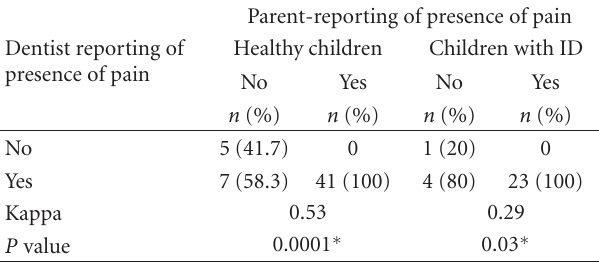
Table 4: Agreement between pain assessments (yes/no) by care- givers and